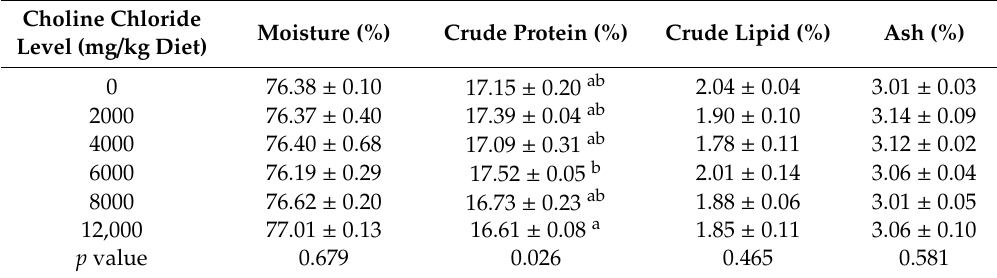
Table 3. Proximate composition of L. vannamei fed di ff erent levels of dietary choline chloride (n = 4, mean ± SE).